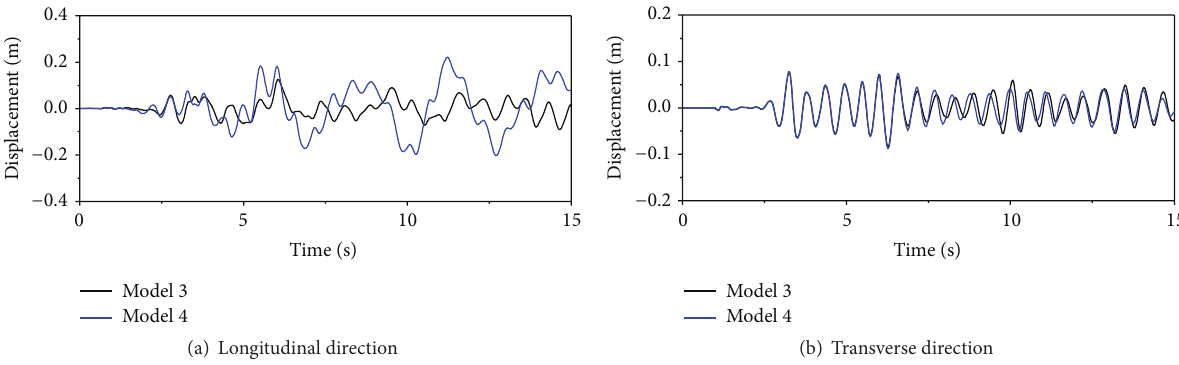
Figure 9: Comparison of the displacement time histories on the top of the transmission towers of the two models of the tension type.